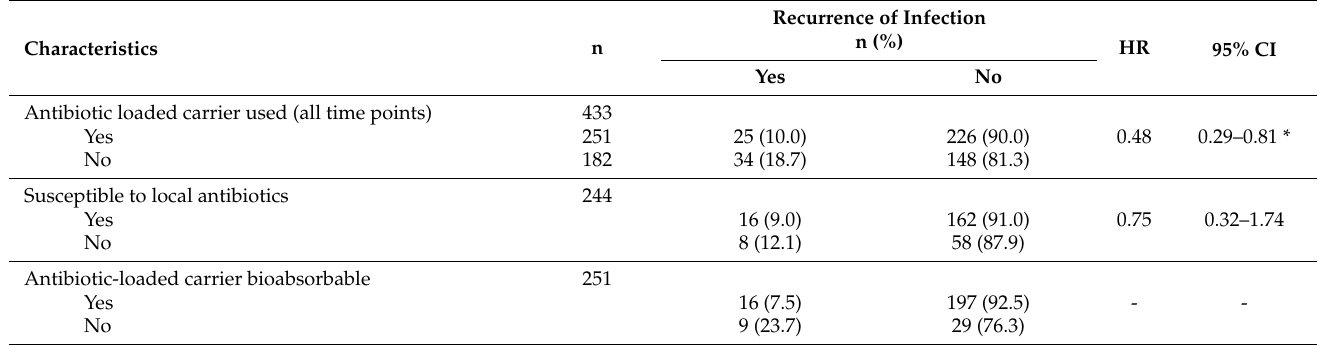
Table 2. The effect of ALCs and the susceptibility to implanted antibiotics on recurrence of infection.